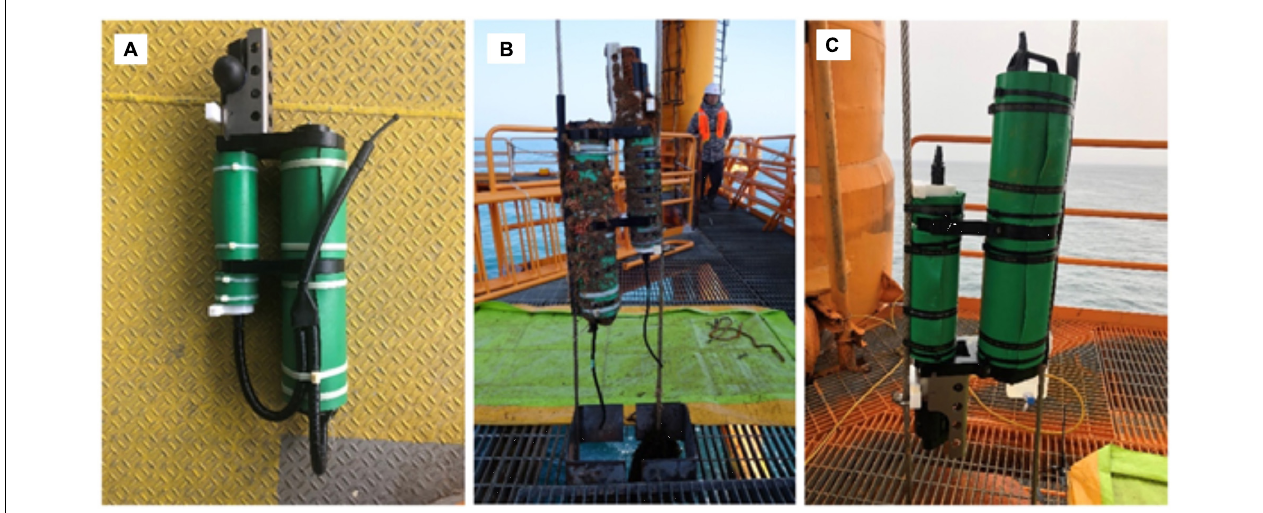
FIGURE 10 | (A) The pre-deployment SeapHOxTM system, comprising two sensor units connected via a Y-cable; (B) the post-deployment SeapHOxTM system, with a broken Y-cable; (C) the disconnected SeapHOxTM system, without a Y-cable, ready for re-deployment.